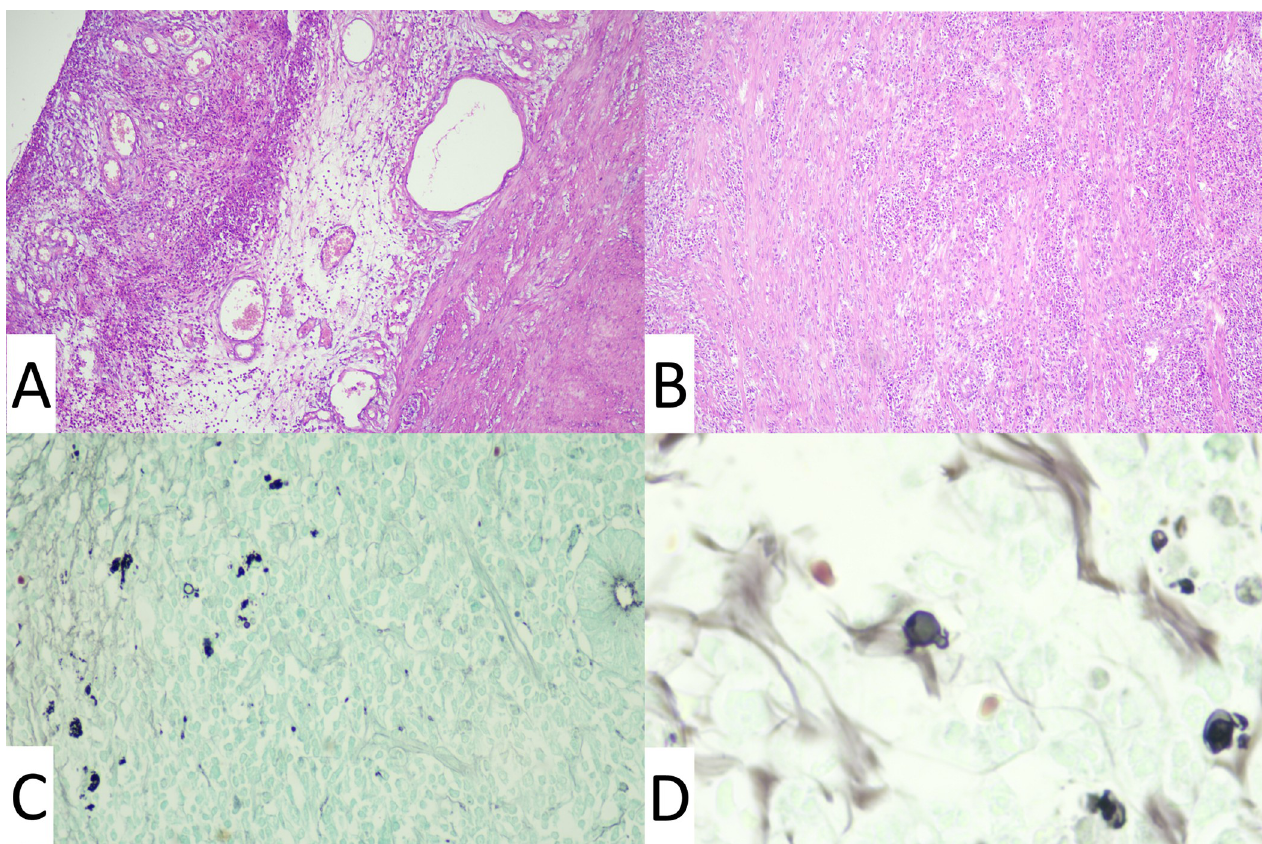
Fig 4. Histopathological examination of the cecal appendix. Acute appendicitis associated with paracoccidioidomycosis. (A) Mixed inflammatory infiltrate, rich in neutrophils, permeating the muscle wall (HE, 100x); (B) Hyperemia, edema, mixed inflammatory infiltrate and fibrinoid exudate in the serous layer (HE, 100x); (C) Round fungal form with single budding and numerous collapsed or fragmented fungal forms (left) and Lieberku¨hn’s crypt (right) (Grocott, 400x); (D) Round fungal form with single budding and fragmented or deformed fungal forms (Grocott, 1000X).